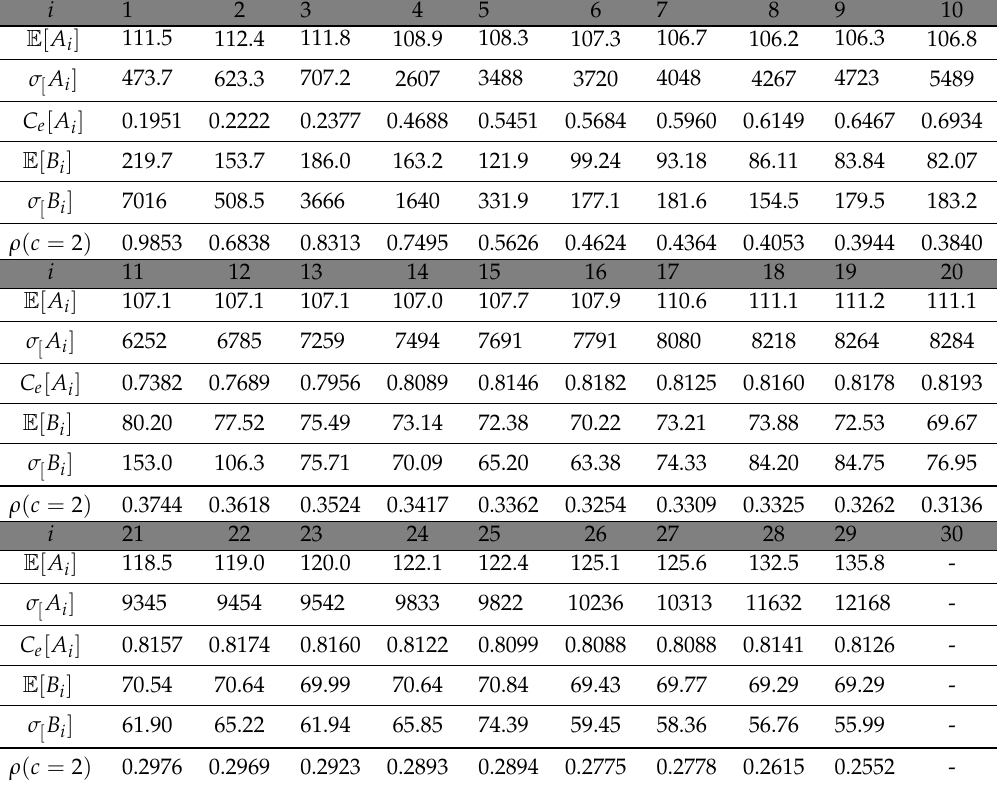
Table 2. Parameters of empirical distributions of the inter-arrival time and service time in